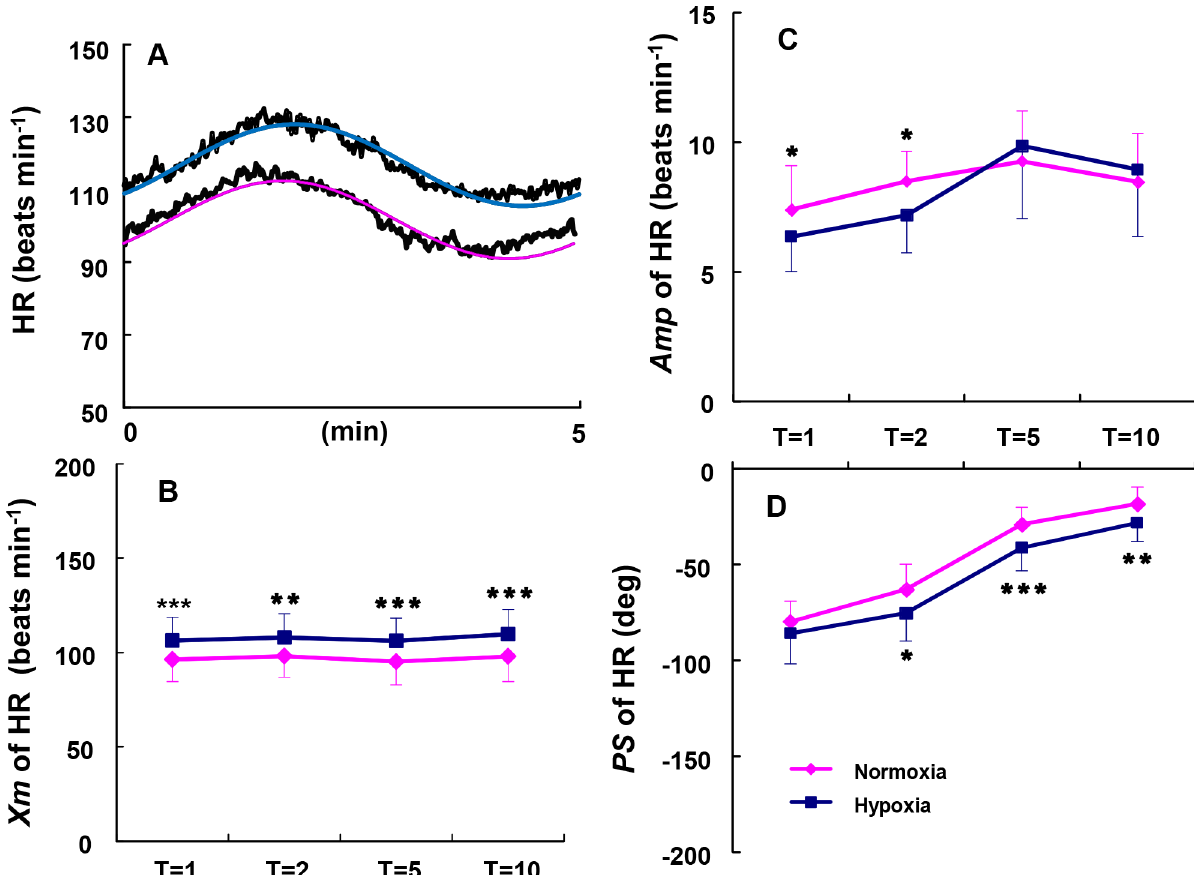
Fig 4. Comparison of the Amp and PS of HR kinetics between hypoxia and normoxia. Differences in the dynamic responses of a representative subject’s HR between normoxia and hypoxia at the representative sinusoidal period of 5 min are shown ( A ). The Mx ( B ), Amp ( C ), and PS ( D ) are shown for hypoxia (blue lines) and normoxia (red lines) as a function of the periods of the sinusoidal changes in the treadmill speed. (cid:3) p < 0.05, (cid:3)(cid:3) p < 0.01, (cid:3)(cid:3)(cid:3) p < 0.001 for hypoxia vs. normoxia. Data are means ± SD.